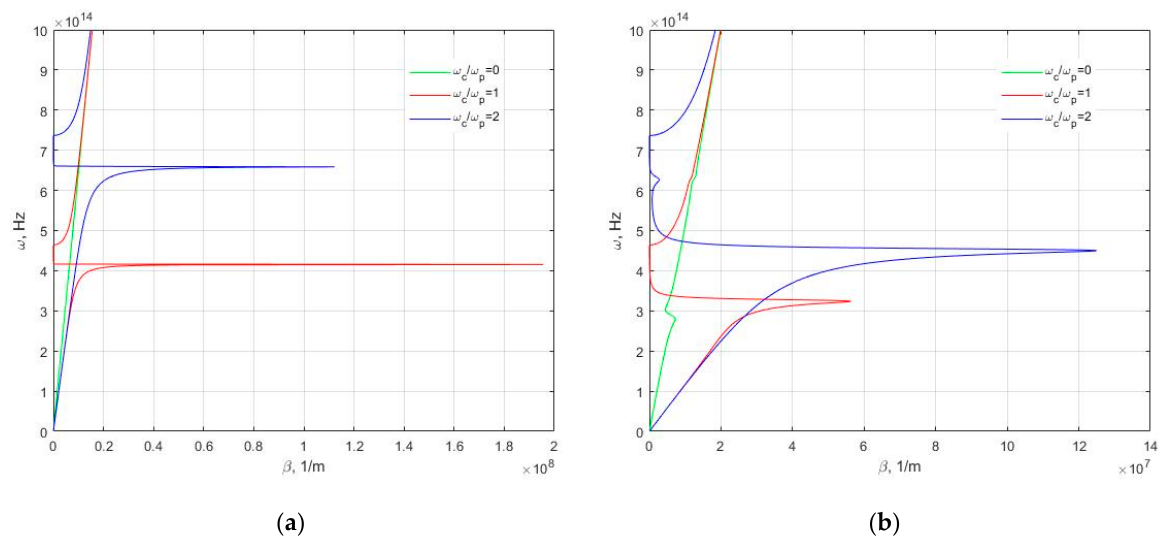
Figure 2. Dispersion diagrams of SPPs for the case of different external magnetic fields. Other parameters are chosen as follows, i.e., nanolayers ( a ): d 1 = 10 nm; d 2 = 20 nm; nanowires ( b ): d = 30 nm, S = 70 nm.